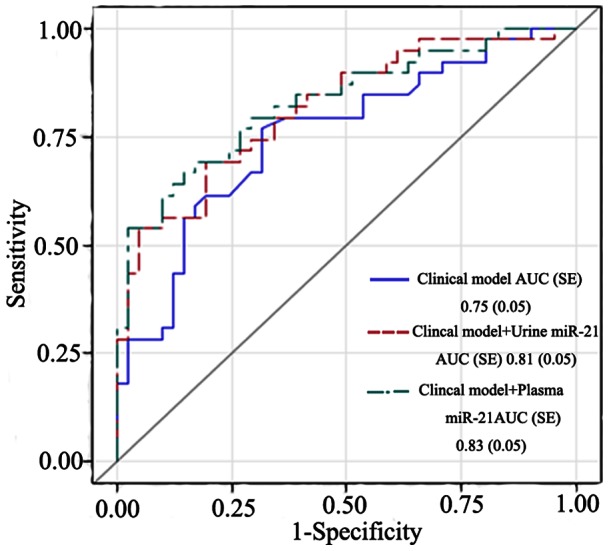
Predictive performance of the urine and plasma value of miR-21 for the progression of AKI.Receiver-operating characteristic (ROC) curves show the predictive performance of the clinical model, clinical model+urine miR-21, and clinical model+plasma miR-21. MiR-21 levels obtained from progressors (n = 39) and non-progressors (n = 41) of AKI group.